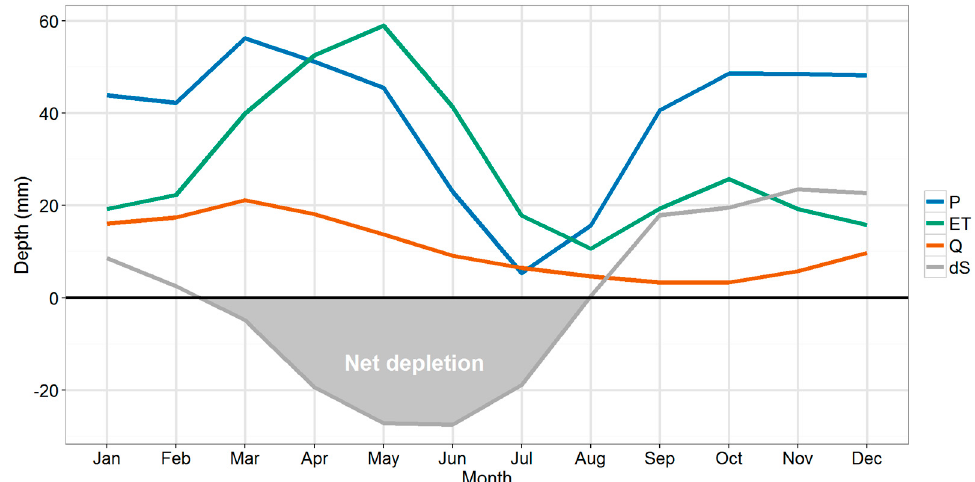
Figure 4 . Average monthly water balance of the basin including precipitation (P), evapotranspiration Figure 4. Average monthly water balance of the basin including precipitation (P), (ET), streamflow (Q) and change in soil and groundwater storage (dS) (all in mm)